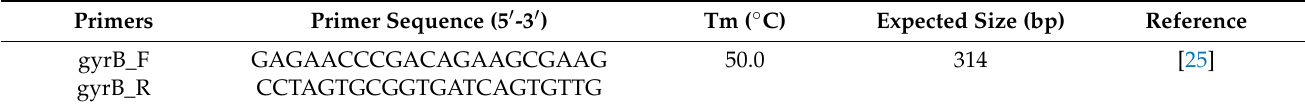
Table 2. Primers used in PCR amplification of gyrB gene.